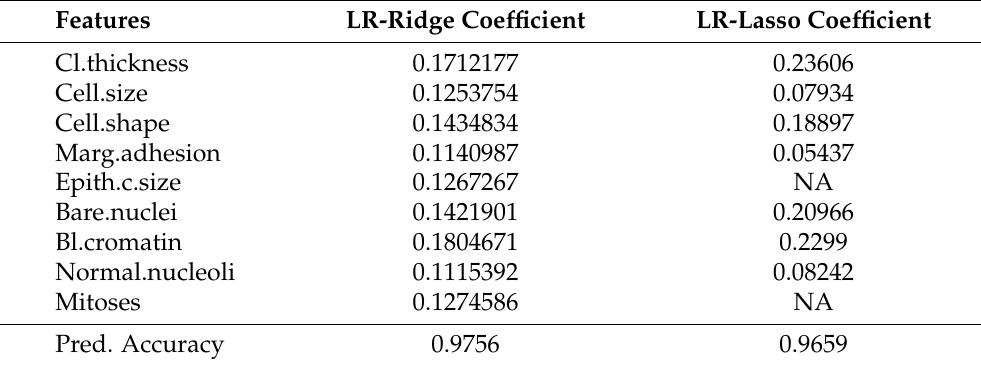
Figure 13. Coefficients for our LR-ridge model for the breast cancer data. The dotted vertical line in the plot represents the λ with misclassification error (MCE) within one standard error of the minimum MCE. Table 3. Coefficient, prediction accuracy of lasso and ridge LR model for the breast cancer